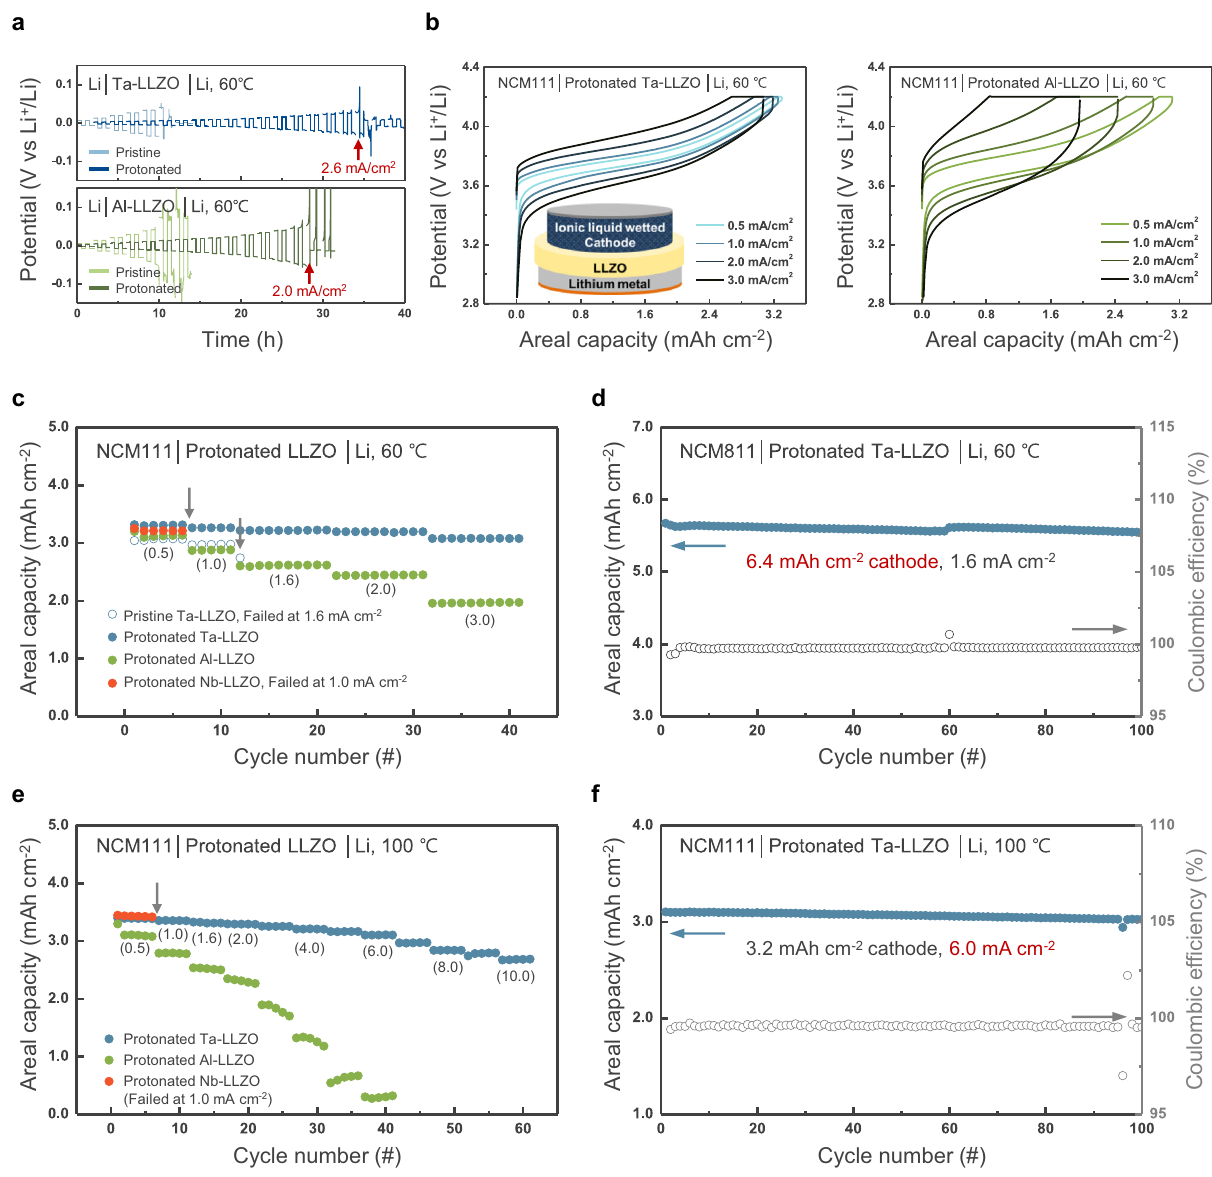
Fig. 3 Electrochemical performance of the cells with surface-tailored LLZOs and Li-metal anodes. a Critical current densities of pristine (light blue and green lines) and surface-tailored (dark blue and green lines) Ta – or Al – LLZO as determined by galvanostatic cycle tests on the symmetrical cells with increasing current densities ranging from 0.1 to 1 mA cm – 2 at a step size of 0.1 mA cm – 2 and from 1.0 to 3.0 mA cm – 2 at a step size of 0.2 mA cm – 2 . At each current density, the cells were cycled twice with 30 min of Li plating/stripping. b Voltage pro fi les of Li/LLZO/NCM111 cells at 60 °C with doped, surface- tailored electrolytes. c Rate capability for various dopants. d Cyclability of surface-tailored Ta – LLZO and an NCM811 cathode with a high capacity of 6.4 mAh cm – 2 at 60 °C. A capacity of 6.0 mAh cm – 2 corresponds to a Li-metal thickness above 30 μ m. e Rate capability of various dopants. f Cyclability of surface-stabilised Ta – LLZO at 100 °C. For the rate capability test at 100 °C, the cells were operated with increasing current densities (indicated with numbers in